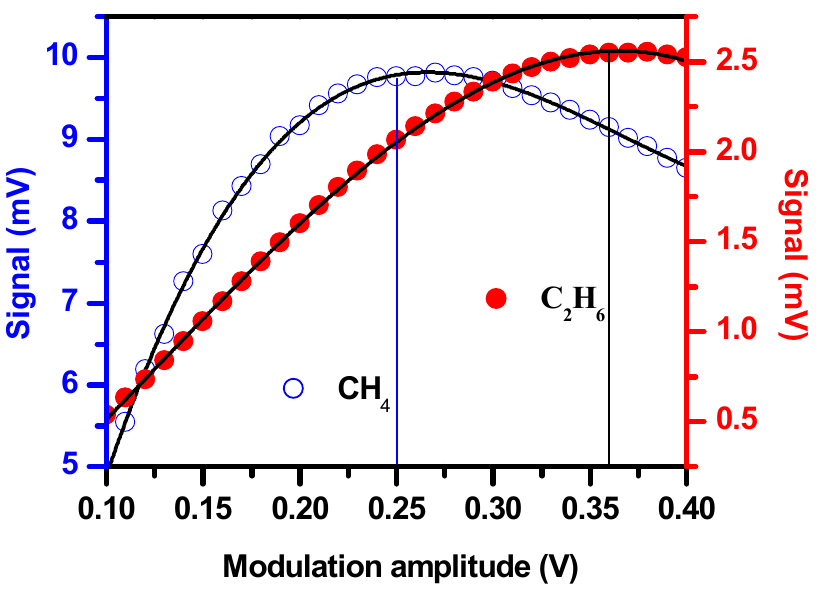
Figure 5. The 2f signals of CH 4 and C 2 H 6 vs. the modulation voltage amplitude.